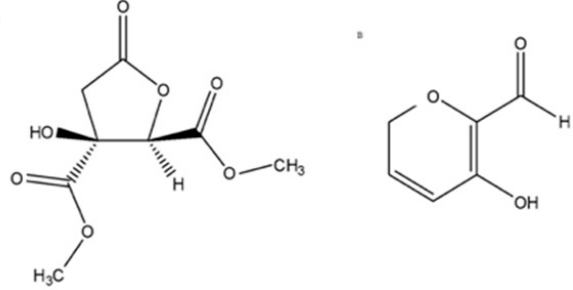
Figure 2. 2D structure of the isolated secondary metabolites Hib-ester ( A ) and Hib-carbaldehyde ( B ).